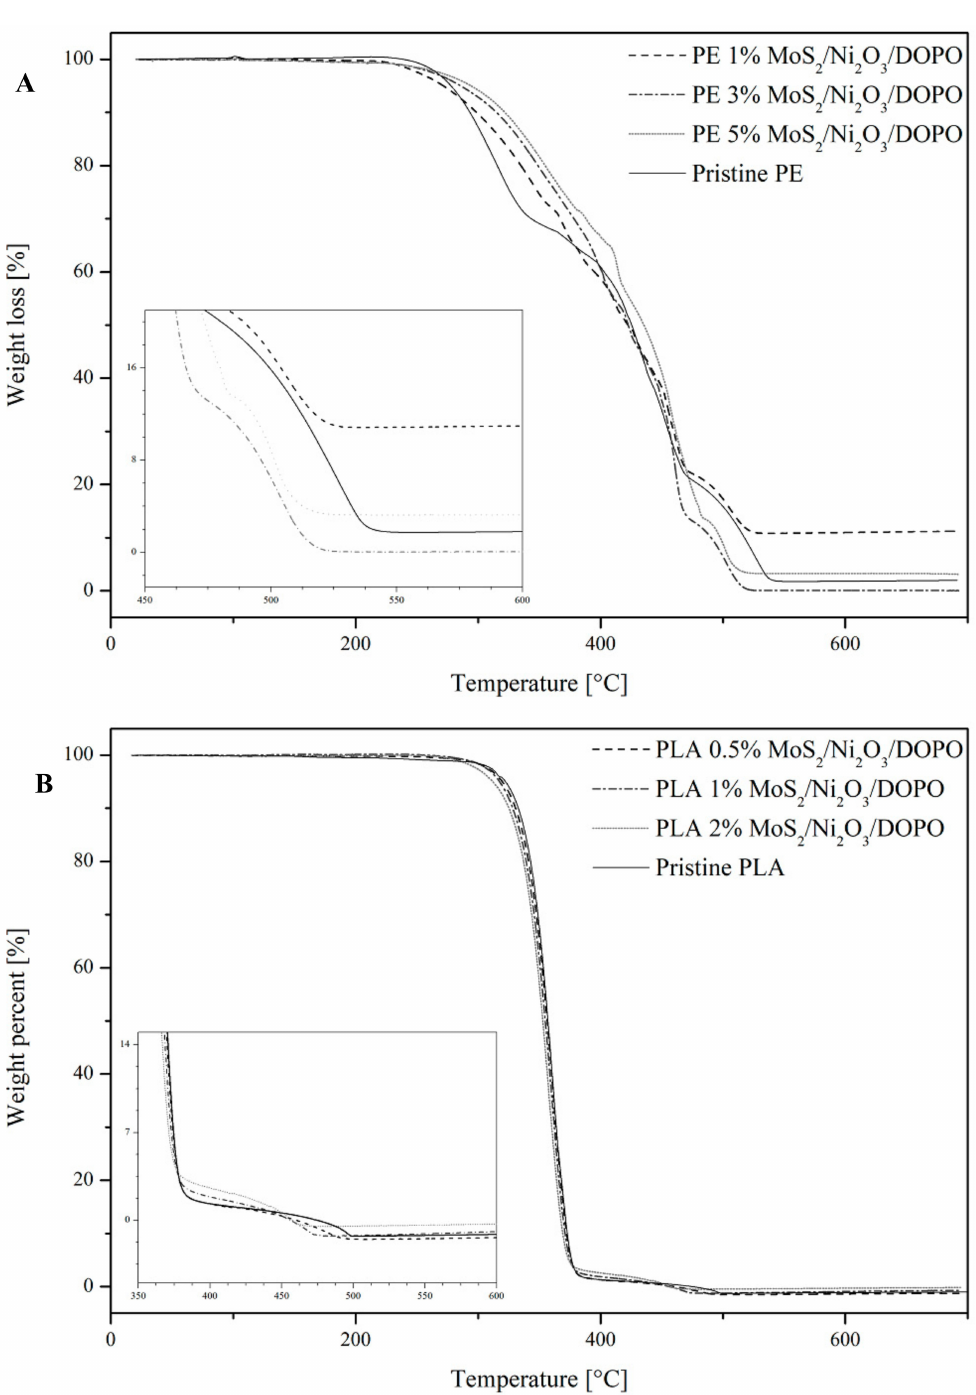
Figure 5. TGA curves of PE ( A ) and PLA ( B ) composites compared to pristine